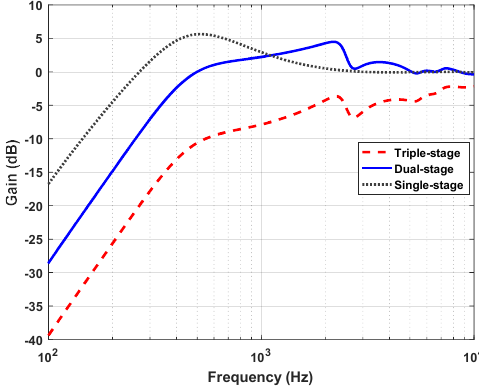
Figure 14. Sensitivity plot of different control schemes.